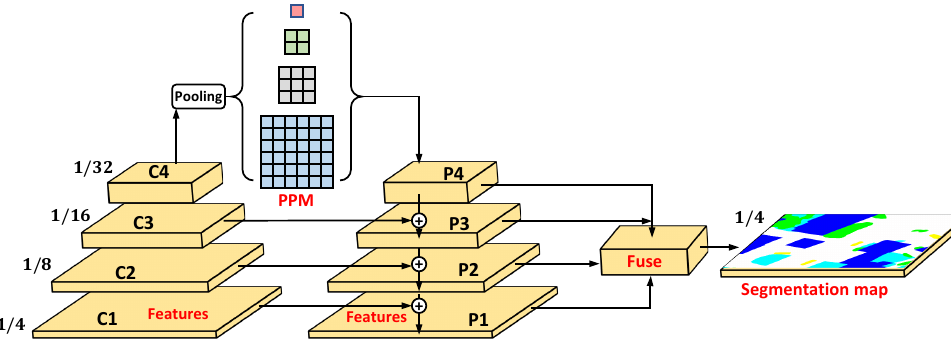
Figure 4. The architecture of